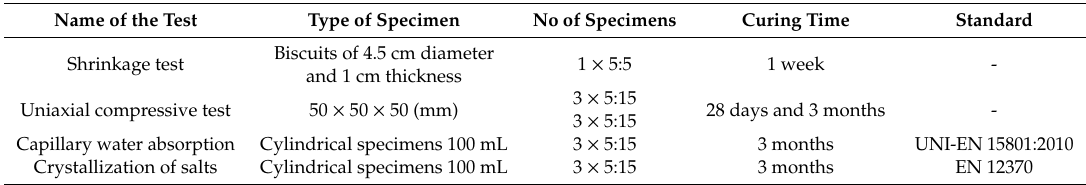
Table 2. Laboratory analyses for proposed